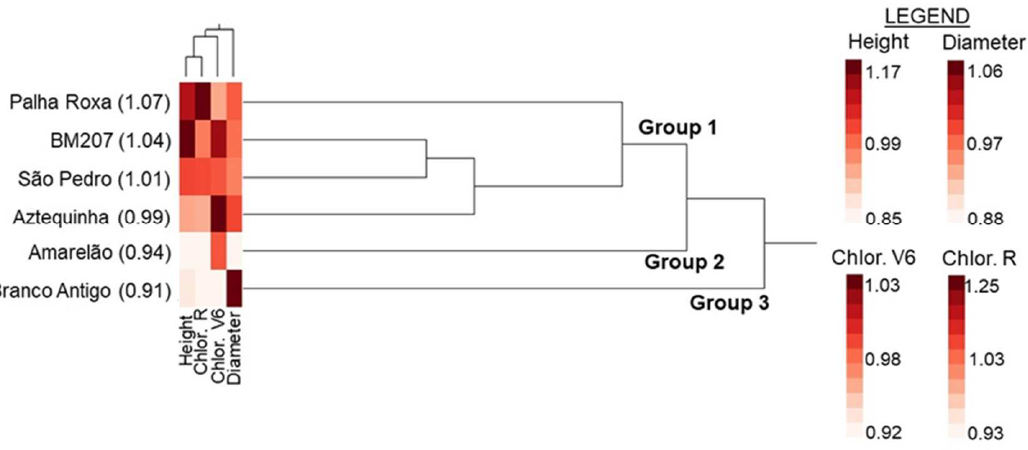
Figure 4. Tolerance ratio to FAW (= plant without insecticide application/average of plants with insecticide application) based on the parameter chlorophyll content at reproductive stage in six maize genotypes ( A ), six genotypes in season 1 ( B ), and six genotypes in season 2 ( C ). In each plot, asterisks indicate statistical difference relative to BM207, per Dunnett’s test ( A ), and per a priori contrasts ( B , C ) with critical p ≤ 0.010 per Sidak’s correction. In each plot, black-filled boxes indicate non-tolerance (undercompensation, ratio < 1), gray-filled (overcompensation, ratio > 1) and white- filled (compensation, ratio = 1) boxes indicate tolerance (critical p = 0.014 per Bonferroni correction). Hierarchical cluster analysis revealed three groups based on similarity across toler- ance indices (Figure 5). The first group included Palha Roxa, BM207, São Pedro, and Az- tequinha; all were considered tolerant to FAW because the geometric averages across the four tolerance ratios were ≈1.0–1.1 for each of these genotypes. The second group included only Amarelão, and the third group only Branco Antigo; both groups were considered not tolerant to FAW because their geometric averages across the four tolerance ratios were ≈0.9 for each of these genotypes (Figure 5).